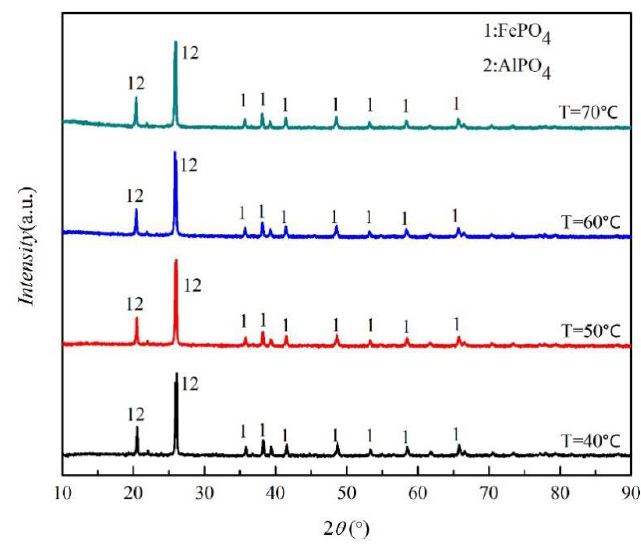
Figure 5. XRD pattern of the sample at different reaction temperatures.